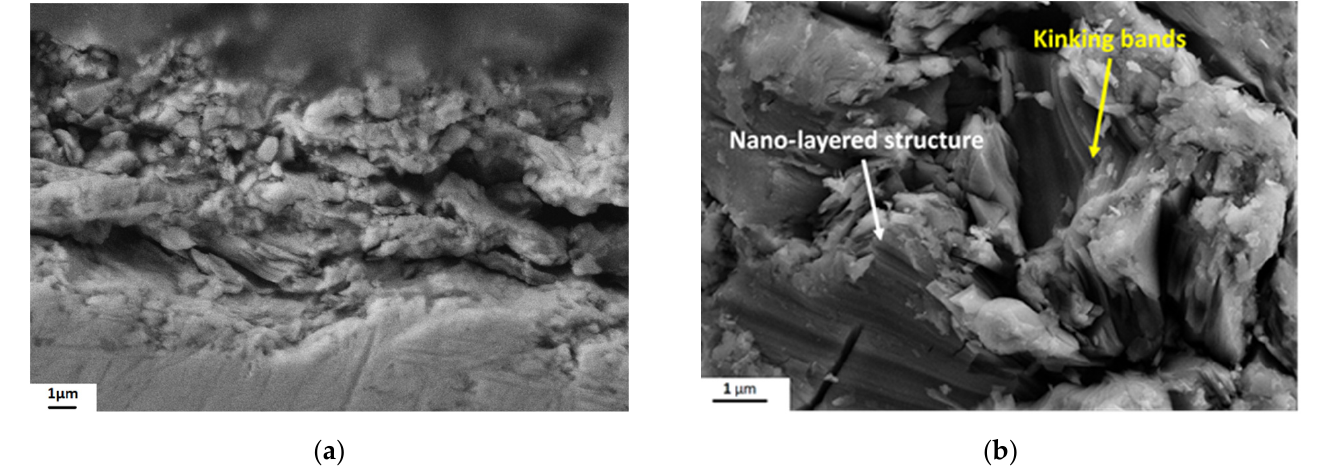
Figure 12. SEM images of Ti 3 AlC 2 coatings deposited at ~780 m/s: ( a ) cross-section; ( b ) top-view SEM image at 10 K magnification that shows the kink bands and the deformation of the nano-layered structure of the Ti 3 AlC 2 particles.